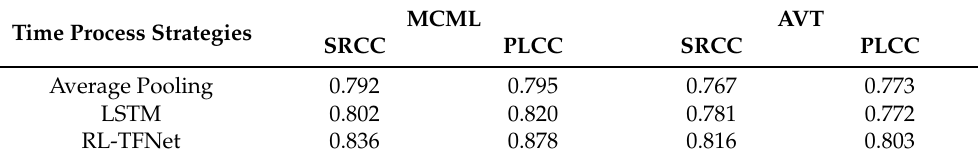
Table 5. Performance comparison of different time-process strategies on two databases. Time Process